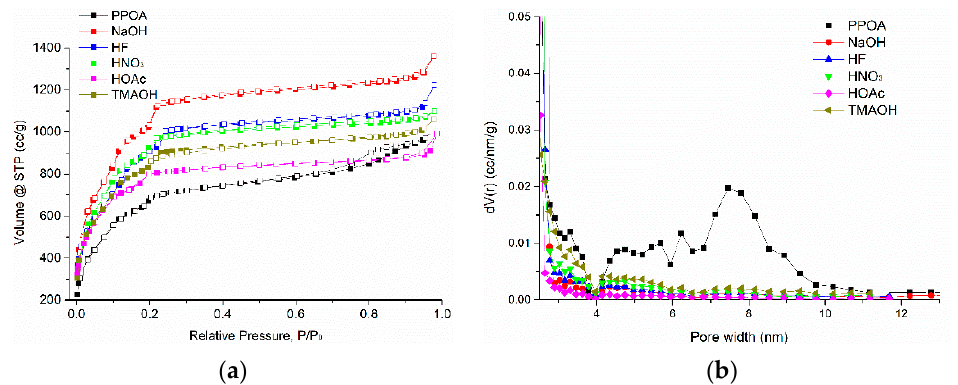
Table 1. The yield, surface area and pore volume of MIL-101(Cr) products with distinct modulators.